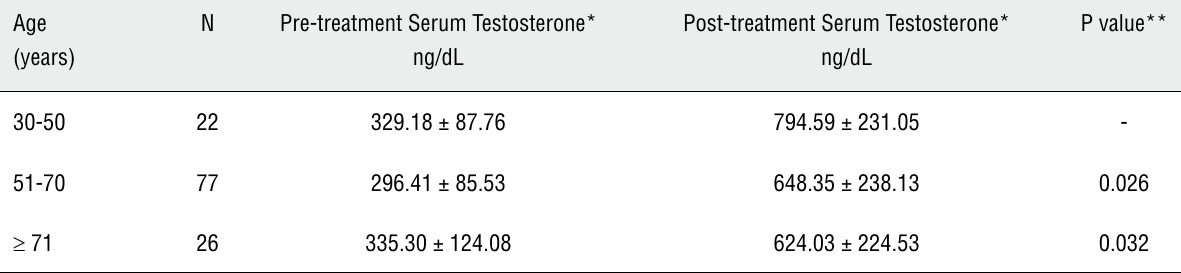
Table 2 - Serum Testosterone Outcomes According To Patient's